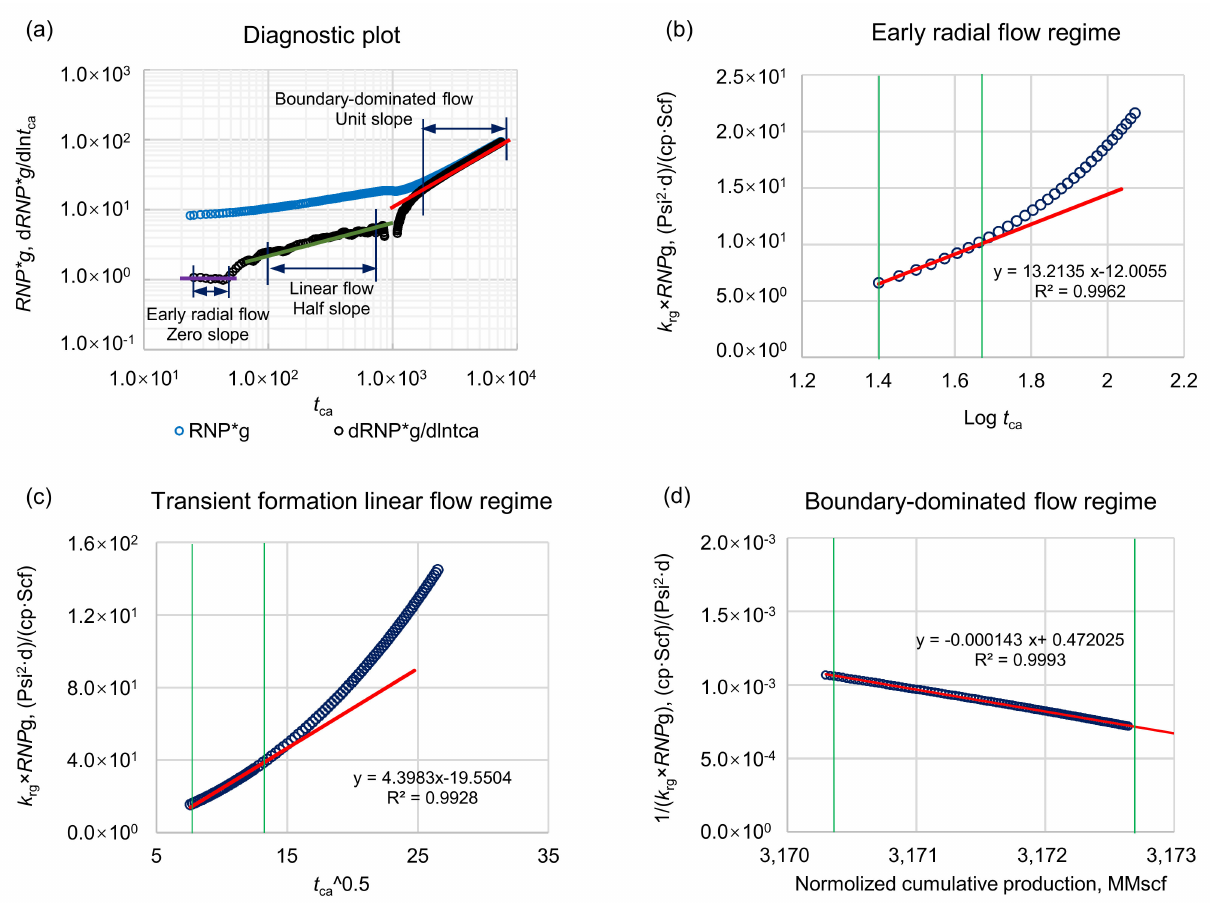
Figure 7. The two phase RTA of the simulated horizontal well in an under-saturated coal seam gas reservoir including ( a ) diagnostic plot, ( b ) early radial flow regime, ( c ) transient formation linear flow regime, and ( d ) boundary-dominated flow